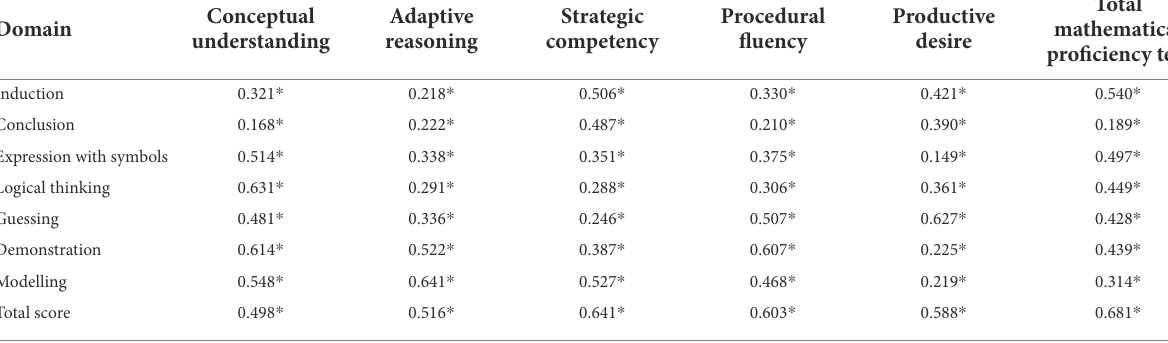
TABLE 5 Pearson’s correlation coefficient between mathematical proficiency and mathematical thinking skills.